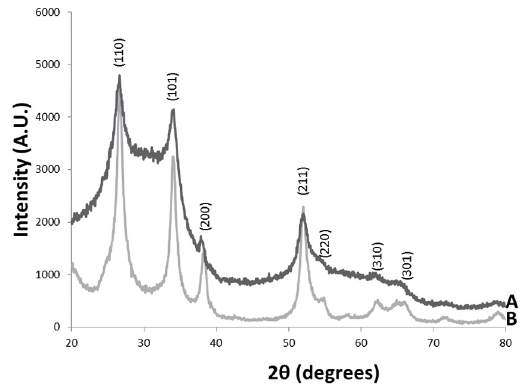
Figure 2: GIXRD patterns of SnO